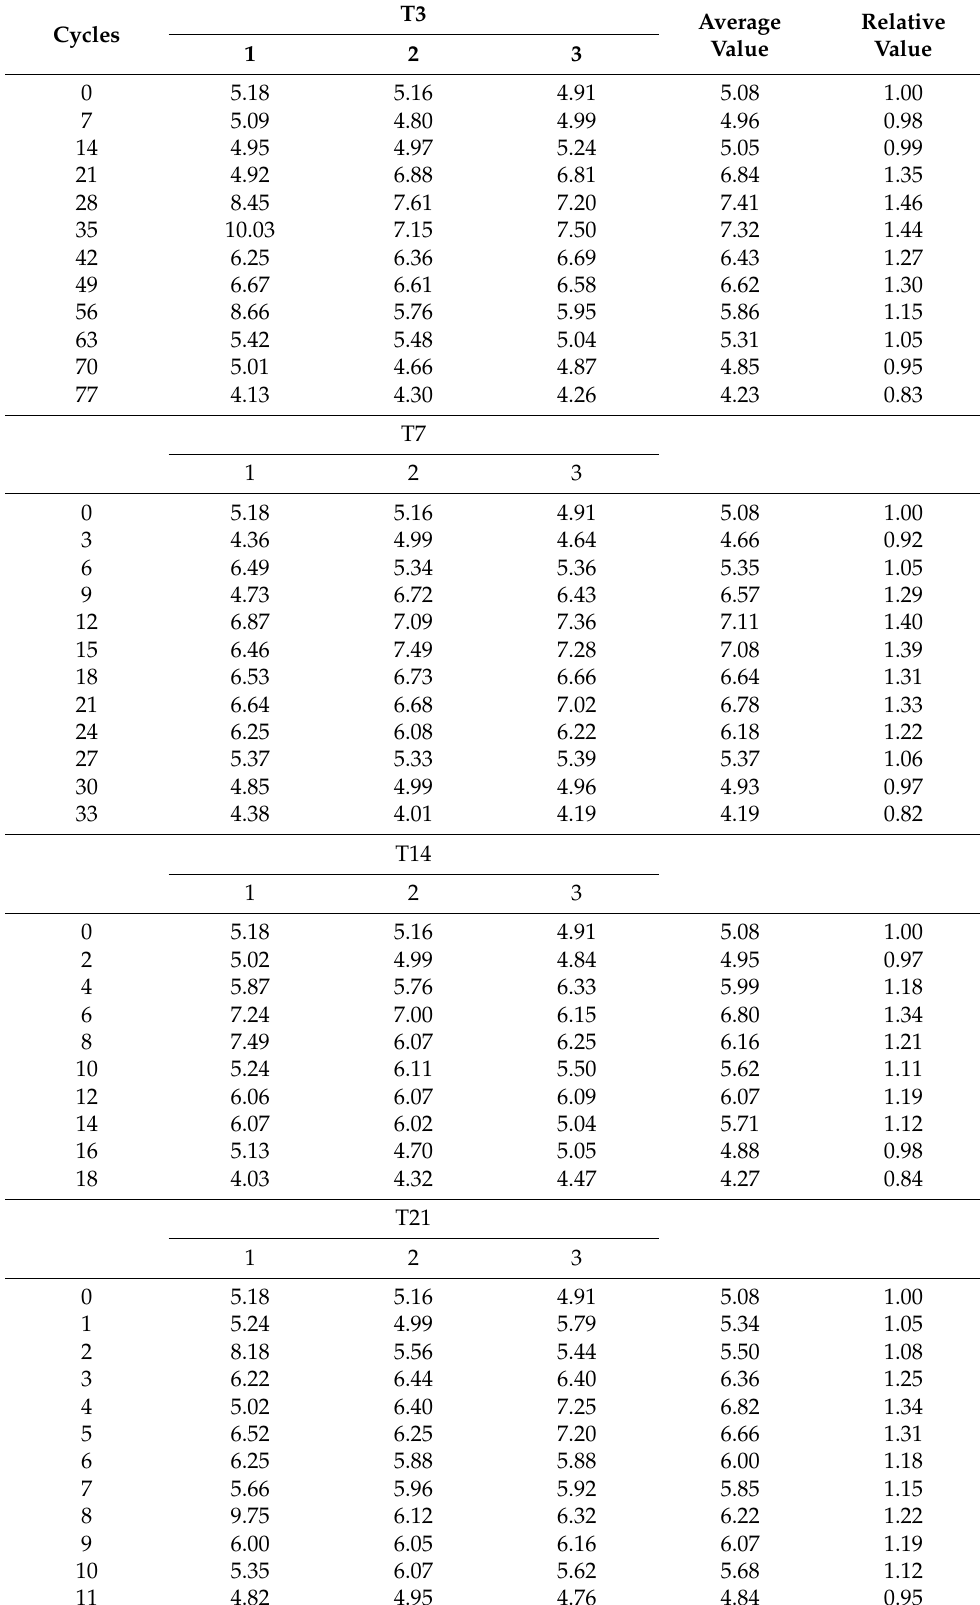
Table 4. The flexural strength in the experiment